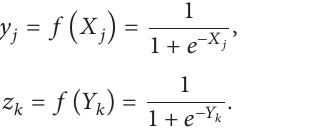
arriving at the processing element via impinging connections and upon values stored in the processing element’s local memory